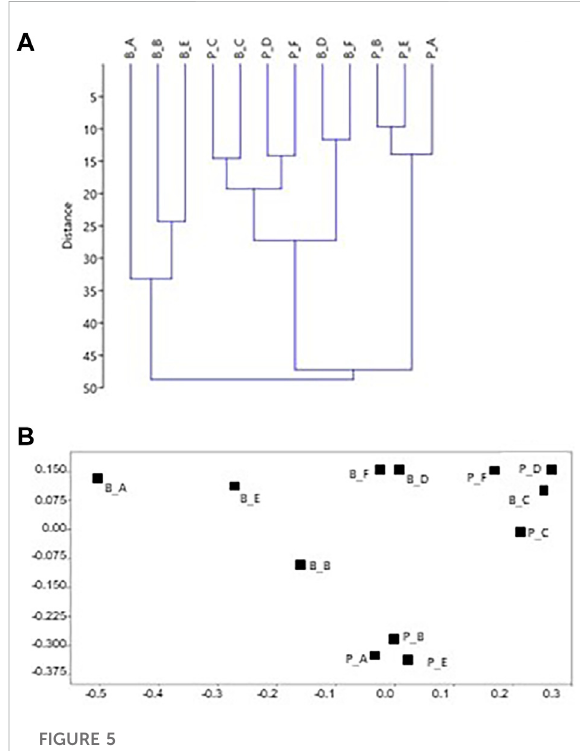
FIGURE 5 Plots of the statistical treatment based on surface coverage data from the two build-ups. Each side is labeled with a fi rst letter indicating the build-up (P=Porto fi no and B=Bogliasco) with another letter indicating the side. For example, P_A is side A of Porto fi no build-up. Euclidean distance, no transformation. (A) Dendrogram (B) 2D plot of the ordination by multidimensional scaling. In (B) the bottom and darker sides are plotted together on the top right. Top left is the shallow well-lit side, while the well-lit deep sides are plotted at the bottom